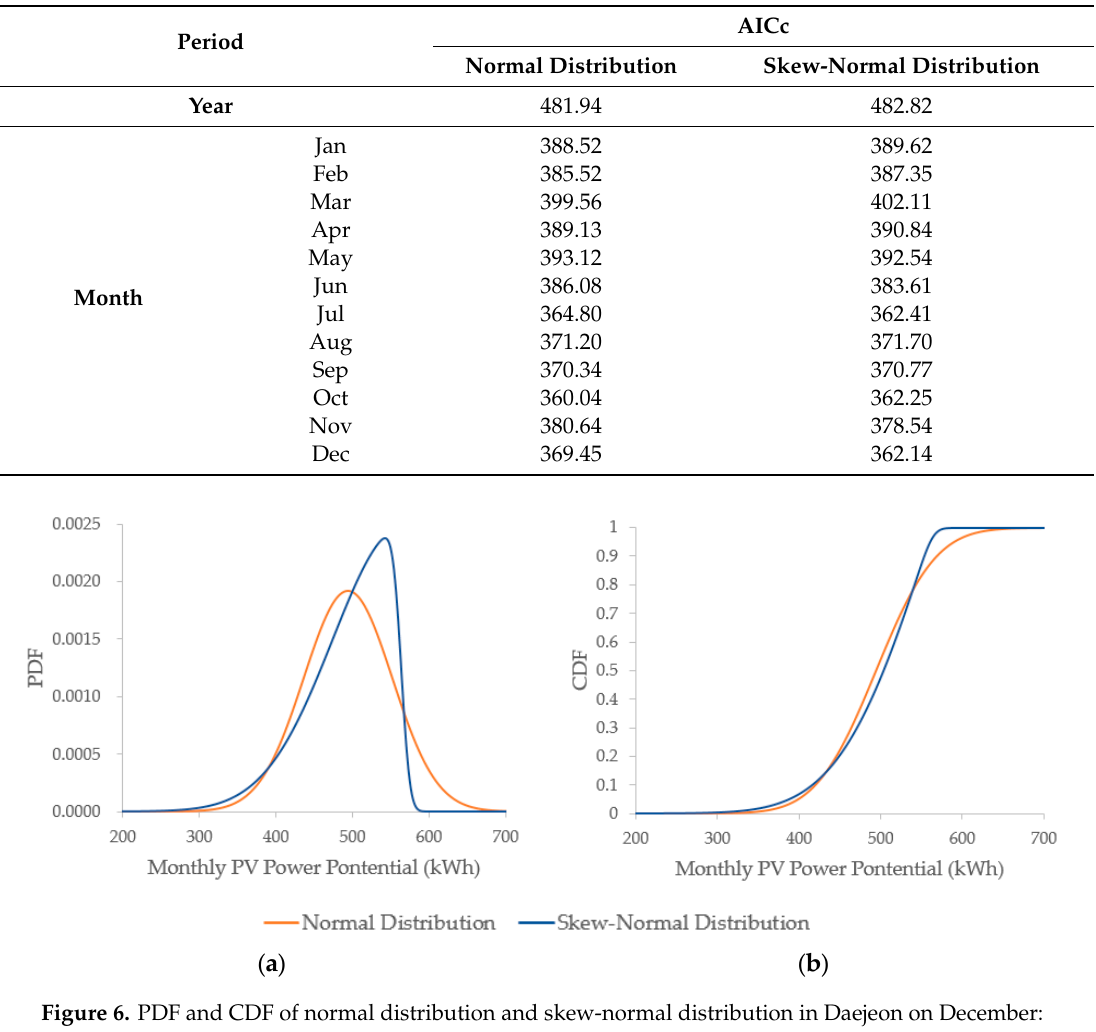
Table 5. Annual and monthly Akaike information criterion (AICc) values in Daejeon.